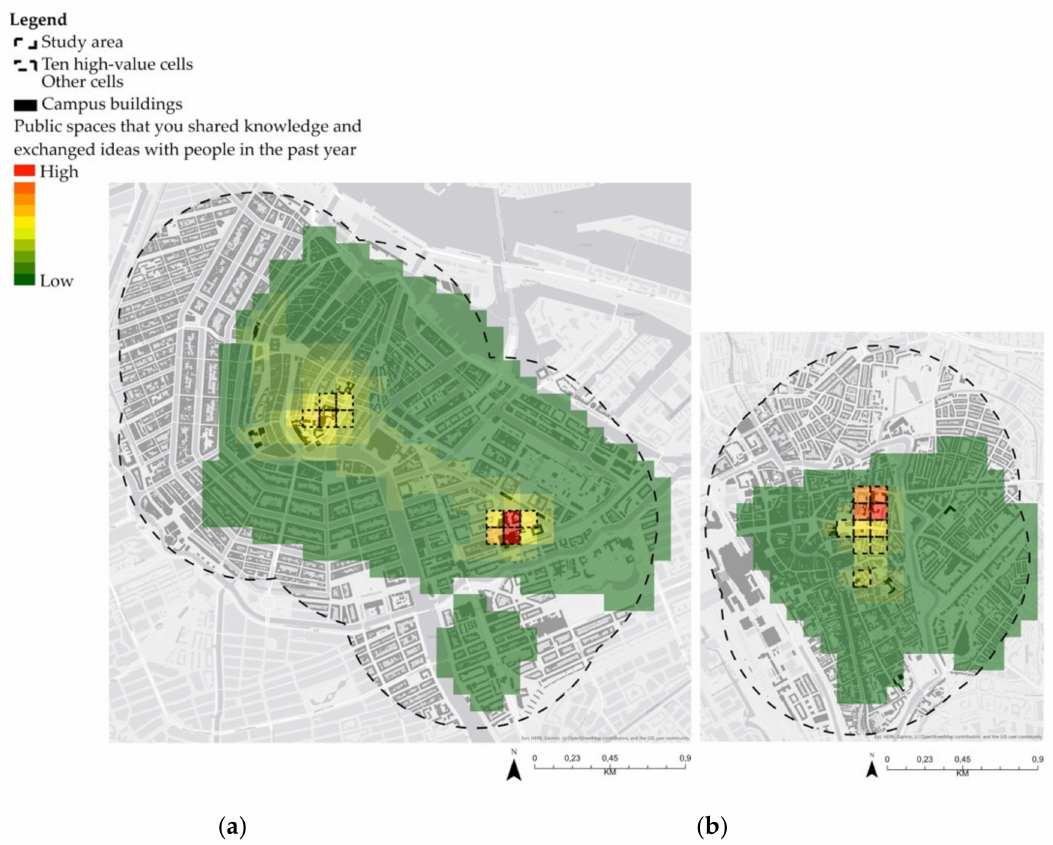
Figure 9. Results of VGI data for inner-city campuses: ( a ) Amsterdam; ( b )